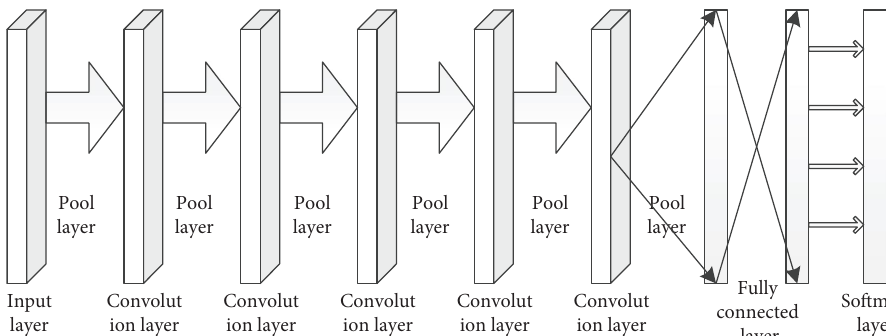
Figure 4: Related composition of deep learning convolution